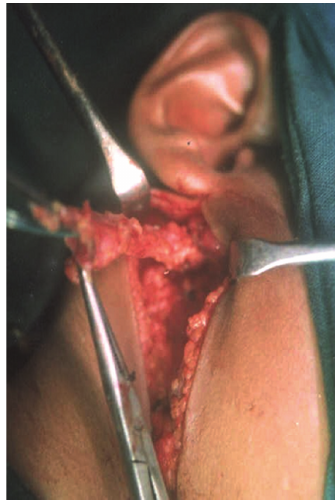
Figure 2: Collaural fistula.